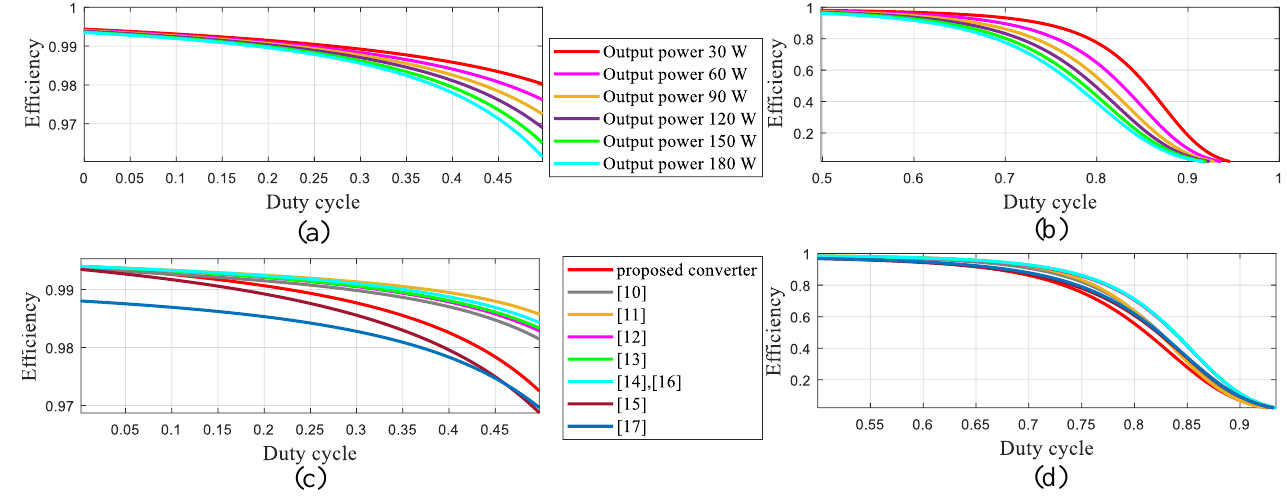
Figure 5. ( a ) Efficiency of the converter for different output powers and the varying duty cycles from 0 to 50 percent; ( b ) efficiency of the converter for different output powers and the varying duty cycles from 50 to 100 percent; ( c ) comparison of the efficiencies of high gain converters for varying duty cycles from 0 to 50 percent; ( d ) comparison of the efficiencies of high gain converters for varying duty cycles from 50 to 100